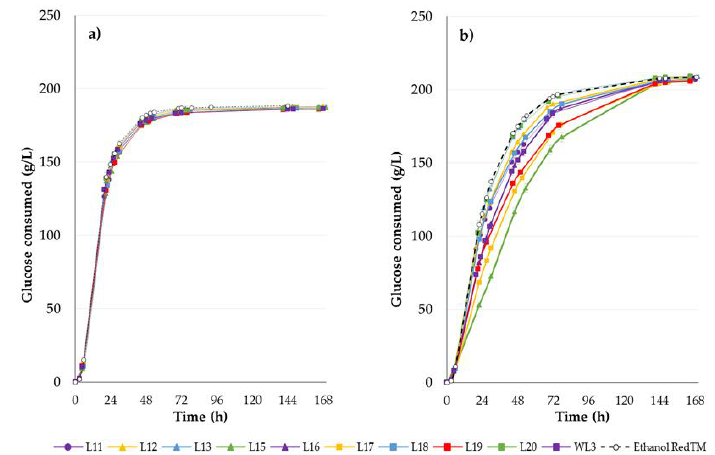
Figure 2. Cumulative sugar utilization (g/L) of S. cerevisiae strains at 30 °C in YNB medium with 20% w/v (a) broken rice or (b) raw corn starch in the presence of STARGEN TM 002. The experiment was conducted in triplicate (±SD).